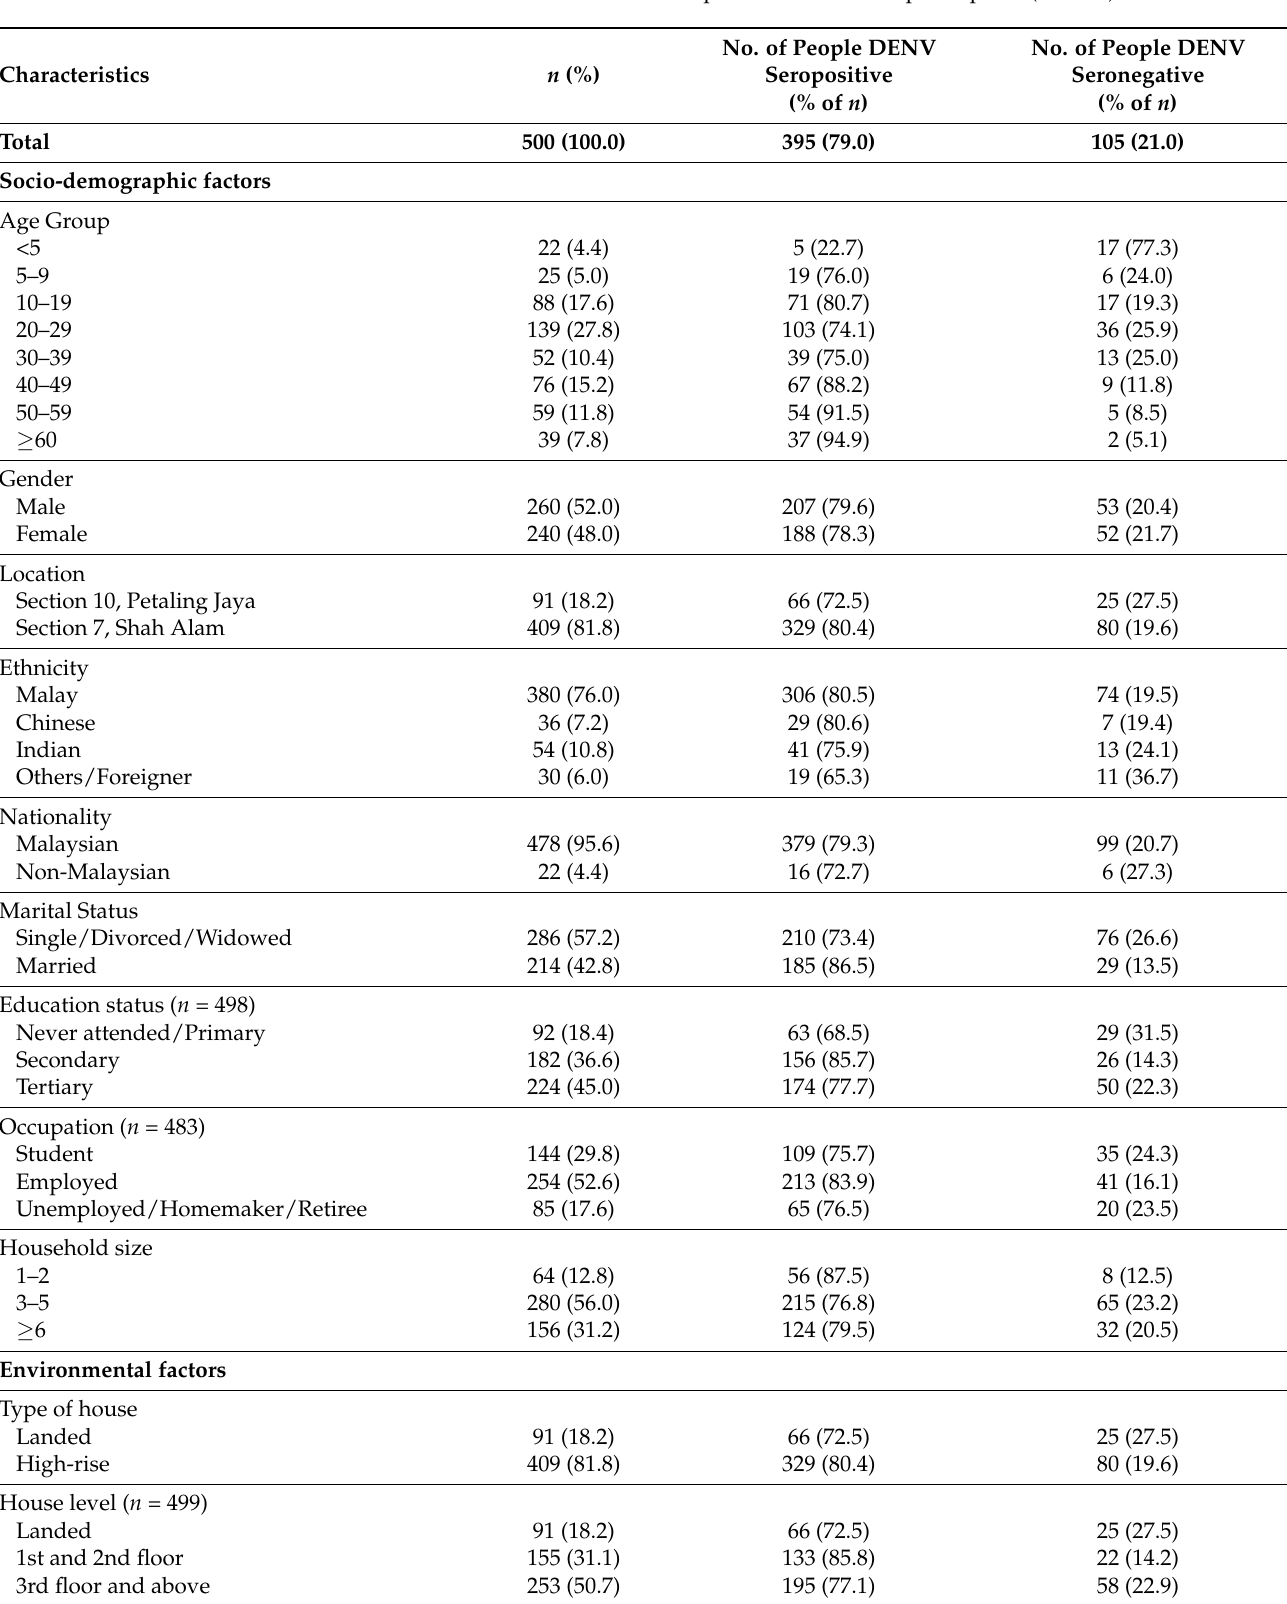
Table 1. Characteristics and DENV seroprevalence status of participants ( n =